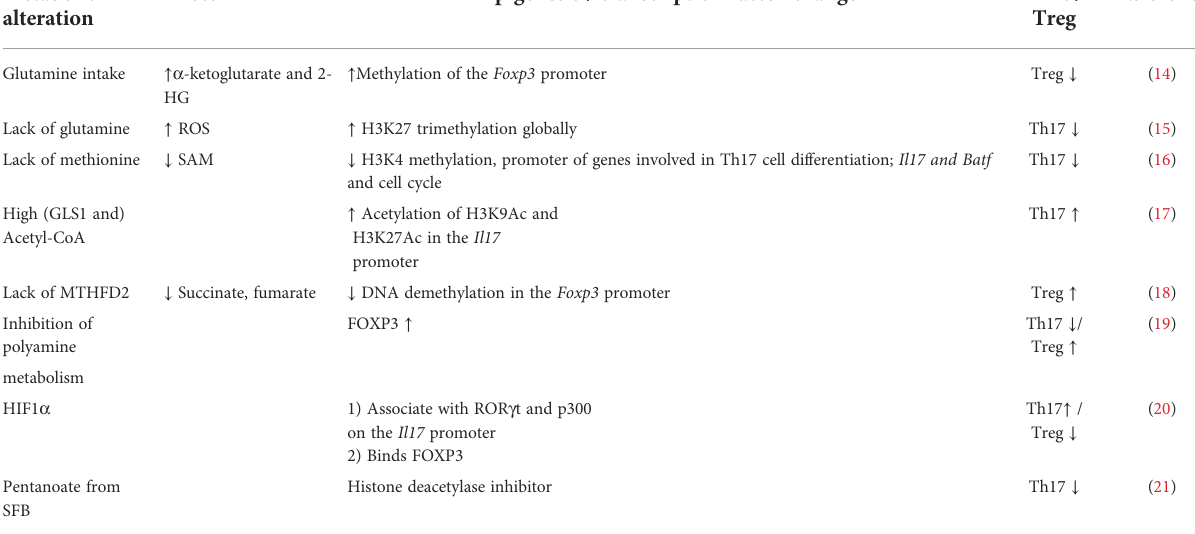
TABLE 1 Metabolic alterations resulting in epigenetic changes to Th17